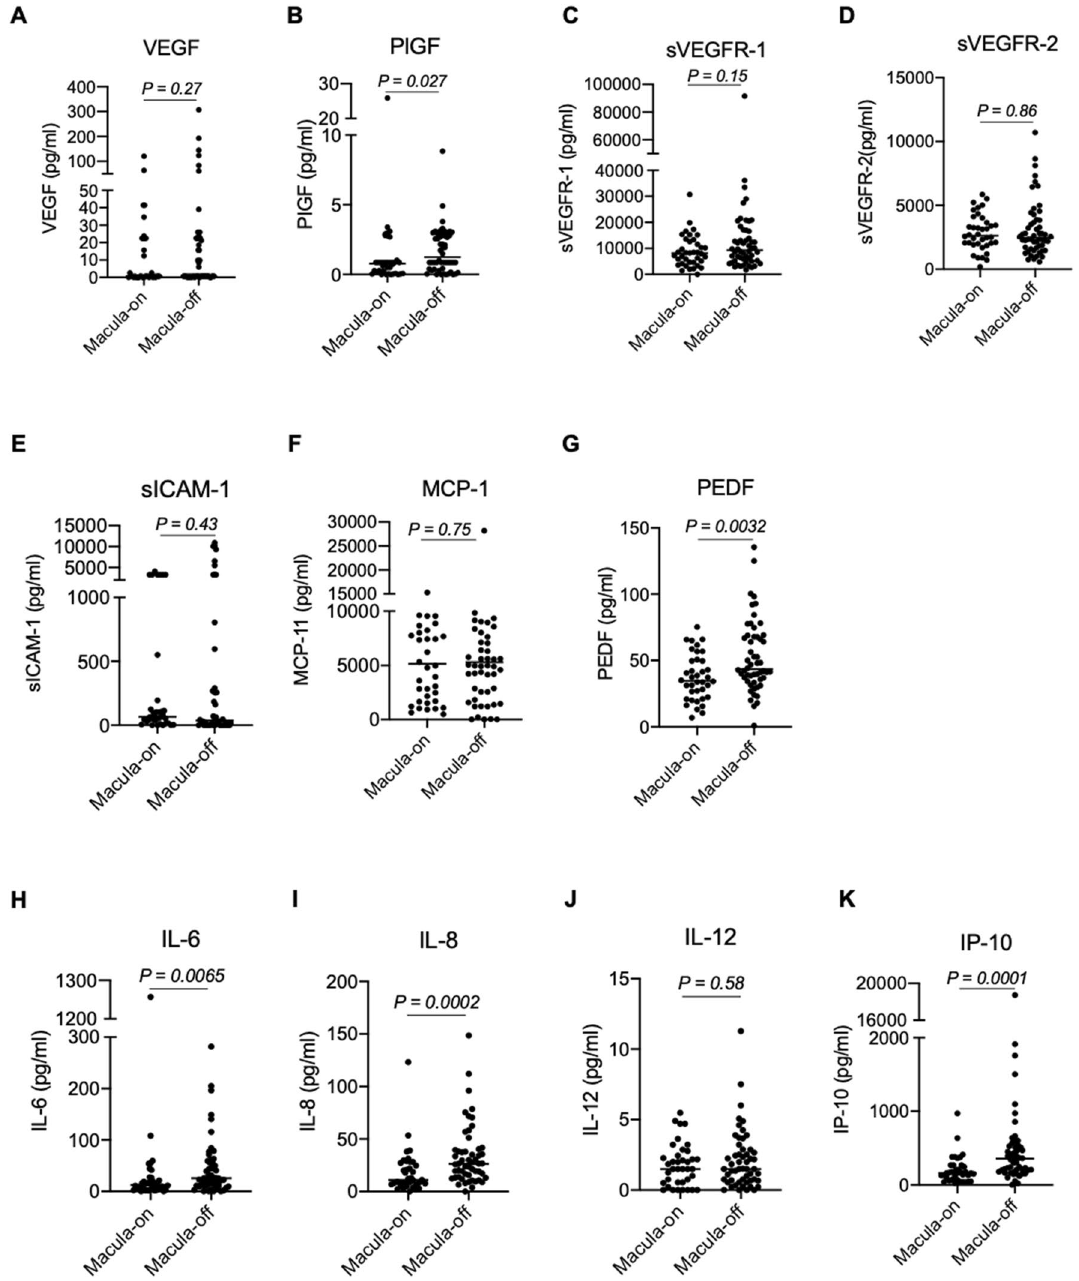
Figure 2. Aqueous humor levels of cytokines in RRD eyes. Vascular endothelial growth factor (VEGF) ( A ), placental growth factor (PlGF) ( B ), soluble vascular endothelial growth factor receptor (sVEGFR)-1 ( C ), sVEGFR-2 ( D ), soluble intercellular adhesion molecule-1 (sICAM-1) ( E ), monocyte chemoattractant protein-1 (MCP-1) ( F ), pigment epithelium-derived factor (PEDF) ( G ), interleukin (IL)-6 ( H ), IL-8 ( I ), IL-12 ( J ), and interferon-inducible 10-kDa protein (IP-10) ( K ) were measured. The levels of PlGF, PEDF, IL-6, IL-8 and IP-10 were significant higher in macula-off RRD than those in macula-on